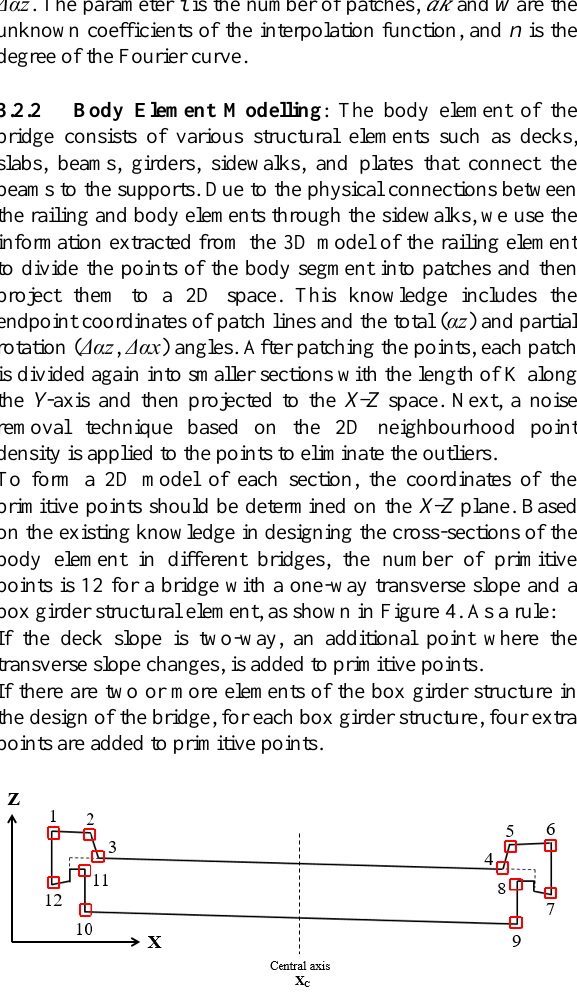
Figure 4. Location of the primitive points in cross-section of the body element.